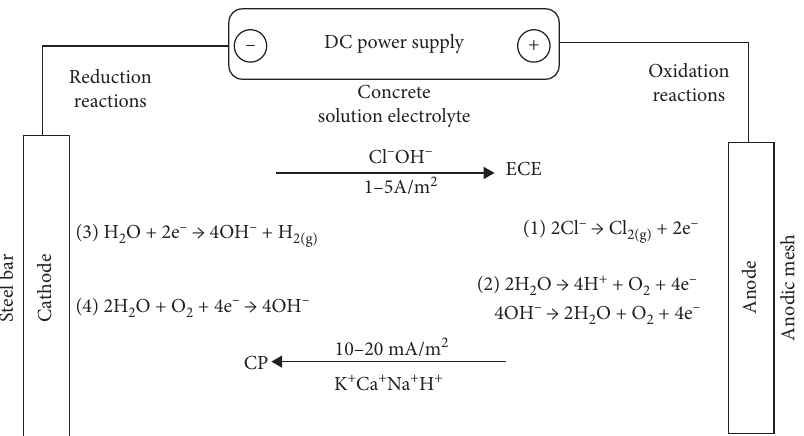
Figure 1: Mechanism of main electrochemical treatments and chemical reactions involved in the processes